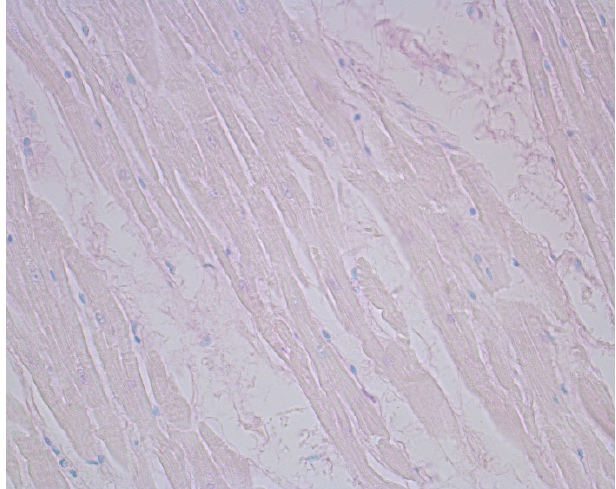
Fig. 7. Heart. Swollen stromal. A sharp decrease in RNA content in cardiomyocytes. Muscle fiber cross-hair